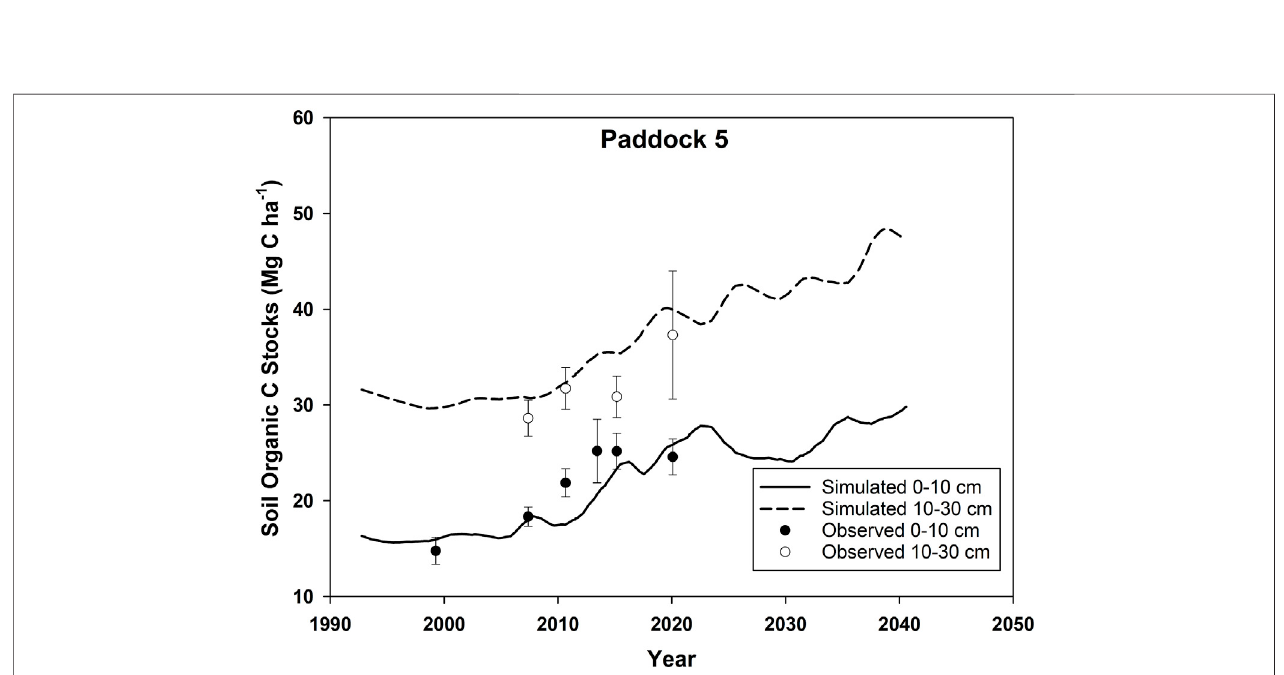
FIGURE5| Simulated andobservedsoilorganiccarbon(SOC) stocksat0 – 10and10 – 30 cmdepths forPaddock 5area,inaTypic Acrustoxsoilunderintegrated crop-livestock system at Santo Antônio de Goiás, GO, Brazil.